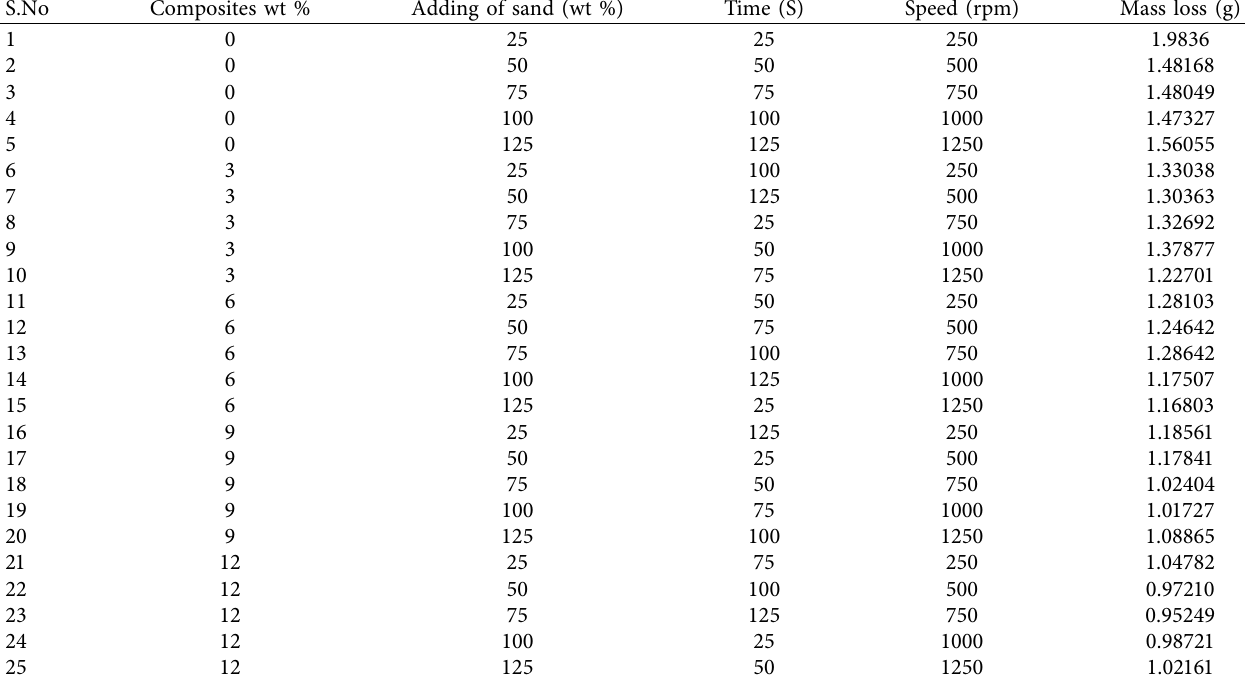
Table 6: With the L 25 orthogonal array, the input and output factors of erosion